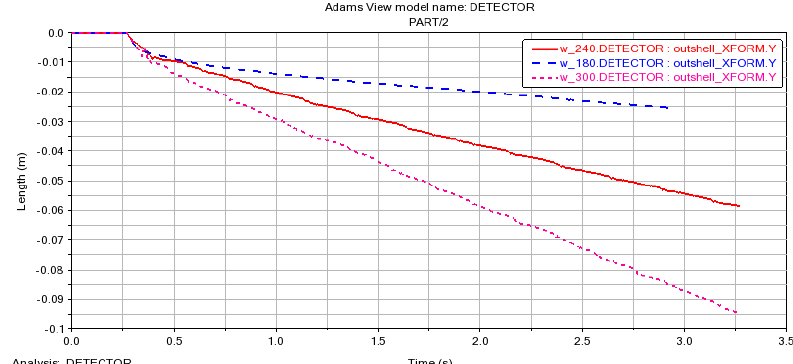
Figure 20. Displacement curves corresponding to different screw rotation speeds.